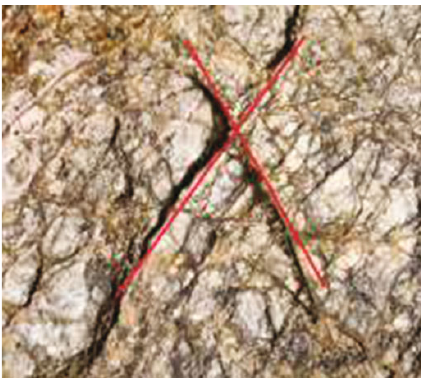
Figure 1: The X-shaped fi ssures in rock mass.